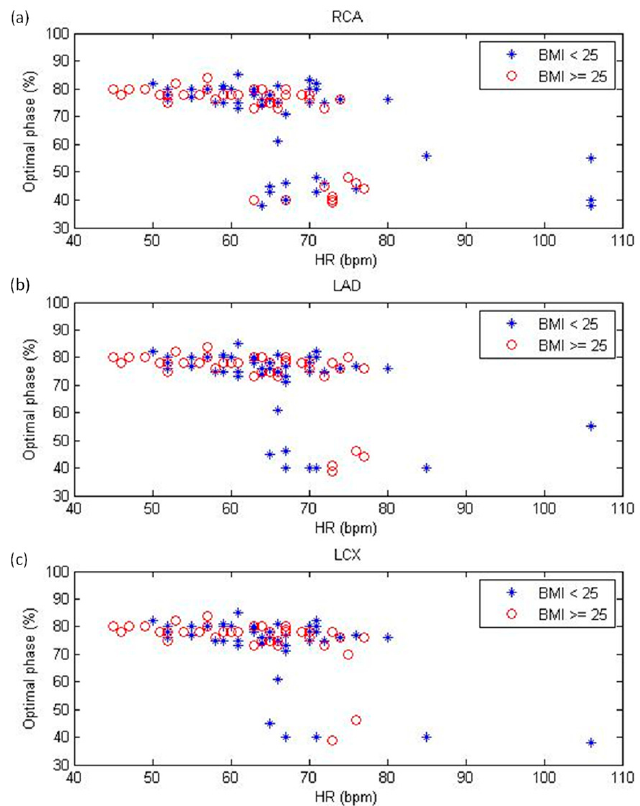
Figure 2. Optimal reconstruction phase for the ( a ) right coronary artery (RCA), ( b ) left anterior descending artery (LAD), and ( c ) left circumflex artery (LCX) as functions of heart rate (HR) on a per-segment basis. BMI = body mass index. Table 2. Comparison of contrast agent doses, scan parameters, and radiation doses in different BMI